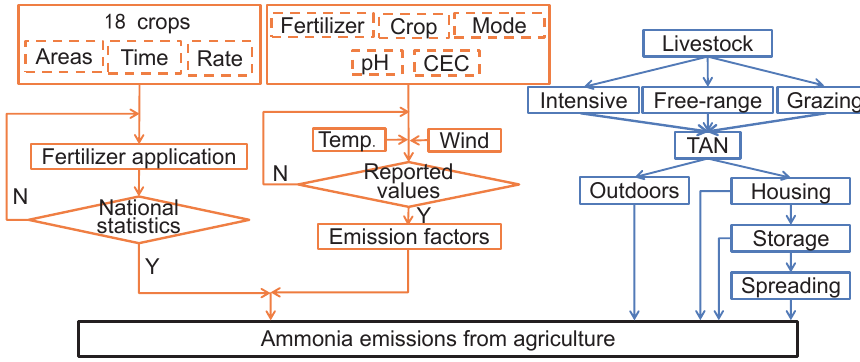
Figure 4. Schematic diagram for estimating agricultural NH 3 emissions from fertilizer application and livestock waste.